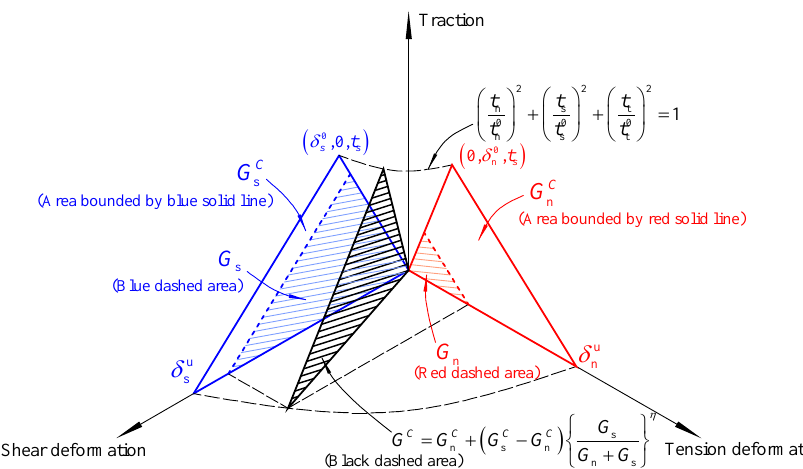
Figure 4. Illustration of quadratic nominal stress criterion and mixed-mode fracture criterion.